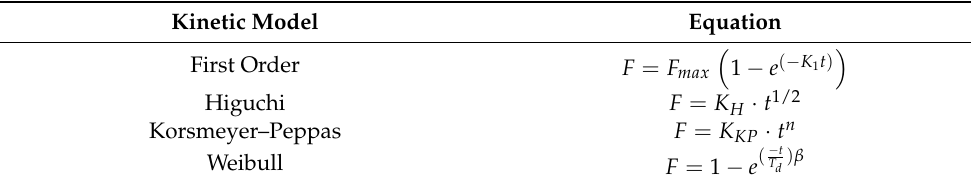
Table 2. Different kinetic models and equations